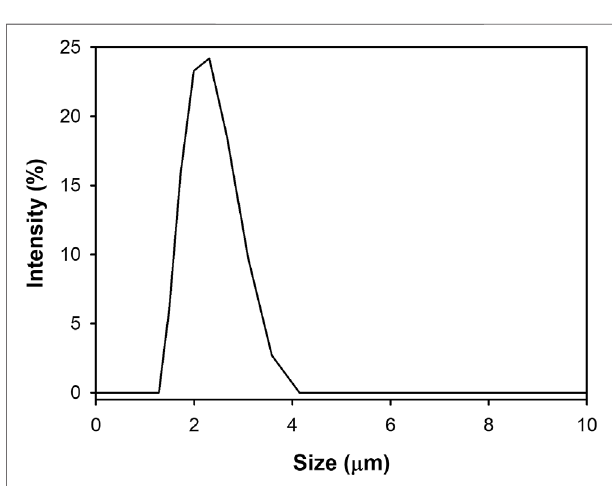
FIGURE 6 | Size distribution of CaCO 3 : Eu.